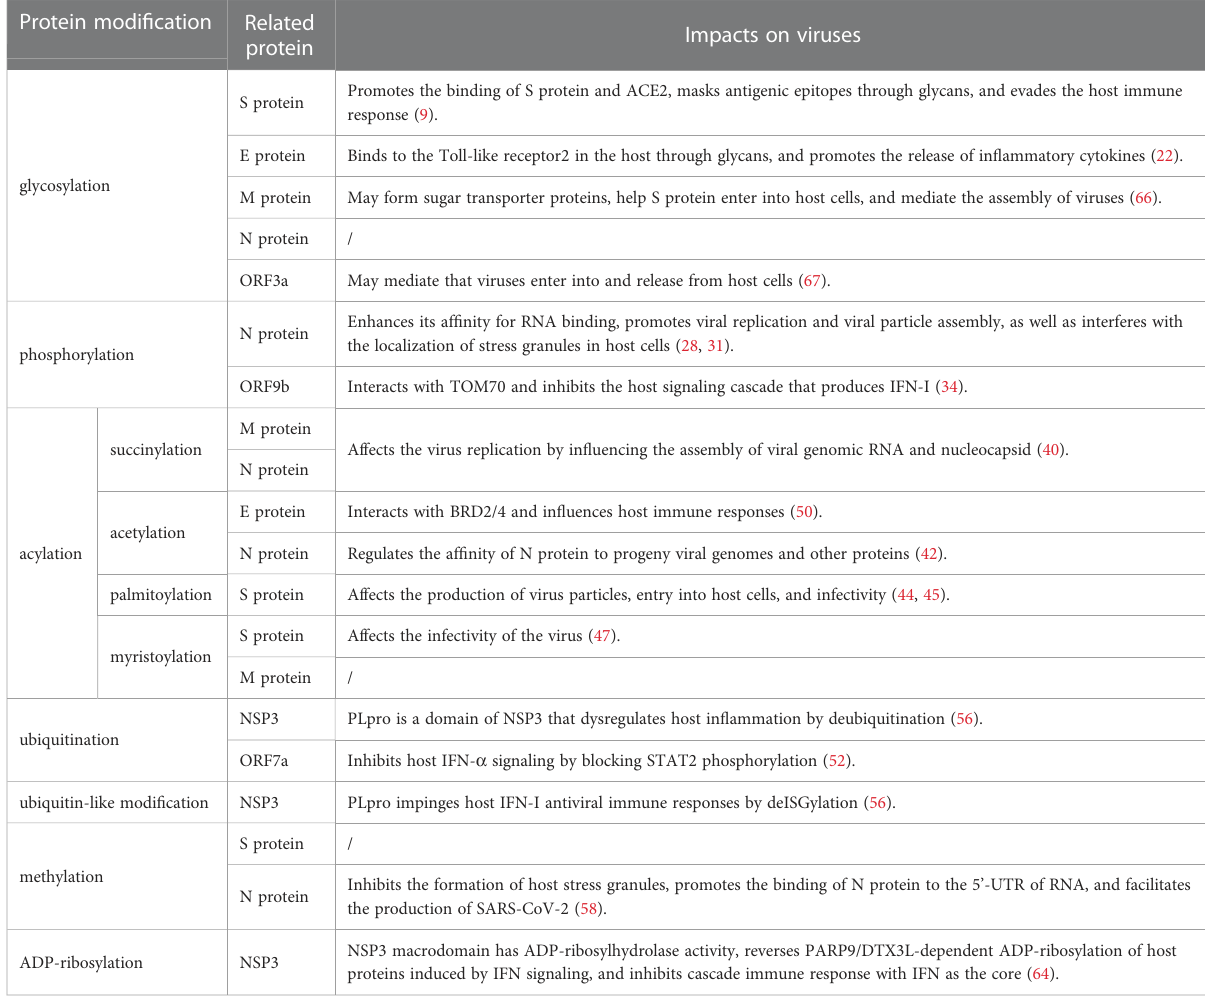
TABLE 1 Effects of PTMs of SARS-CoV-2 proteins on the virus. Protein modi fi cation Related protein